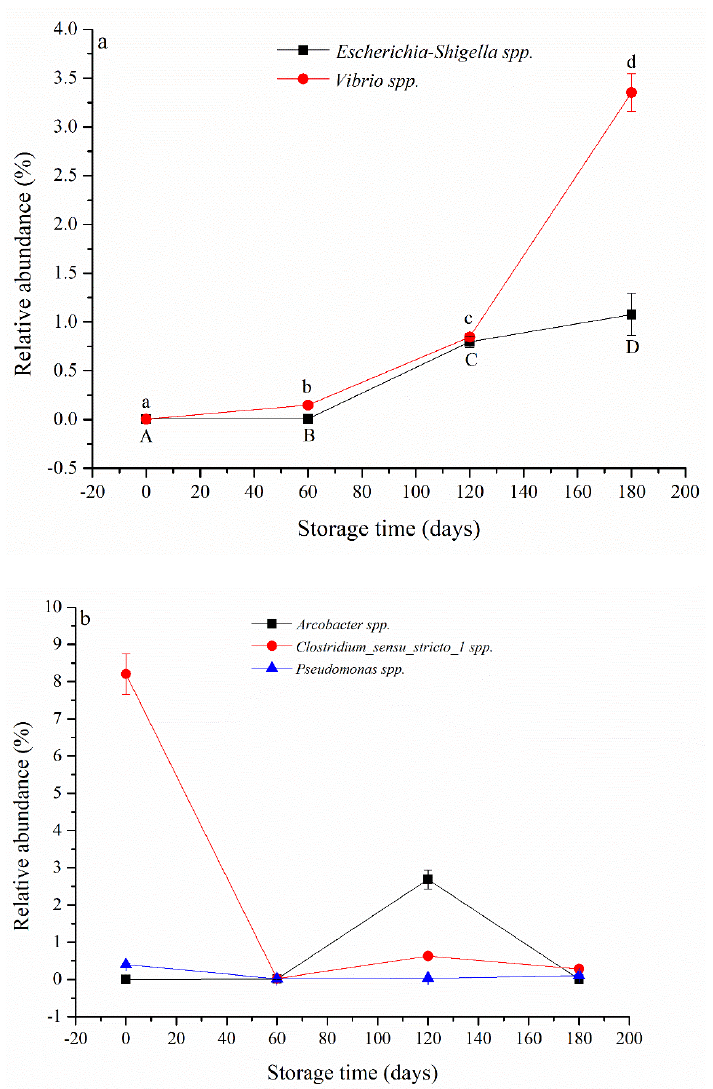
Figure 6. The relative abundance of suspected pathogenic bacterial species on storage days 0, 60, 120, and 180 in swine wastewater. Data are means of three replications, and different letters indicate significance at p < 0.05.